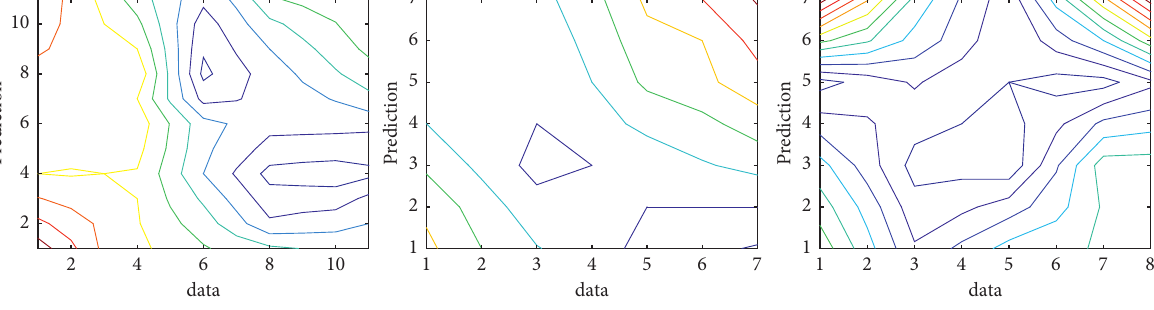
Figure 5: Prediction.